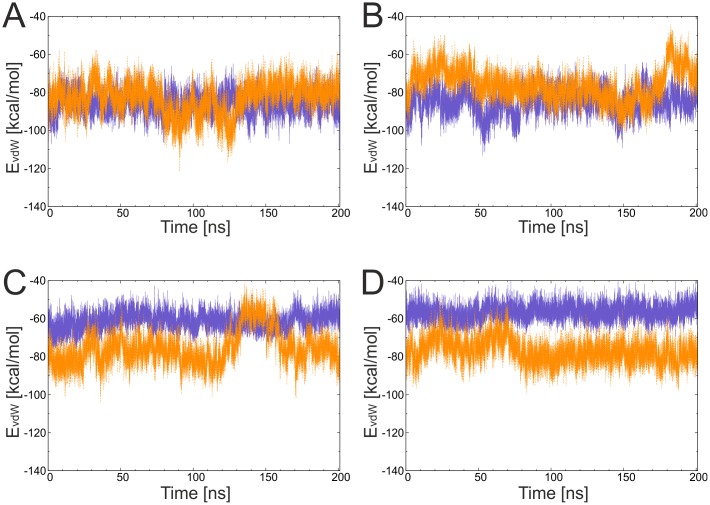
Evolution of van-der-Waals interaction energy of the tag in parent domains (violet) and tag/catcher (orange) constructs.(A) 3phs, (B) 4oq1, (C) 3kptN, and (D) 3kptC.